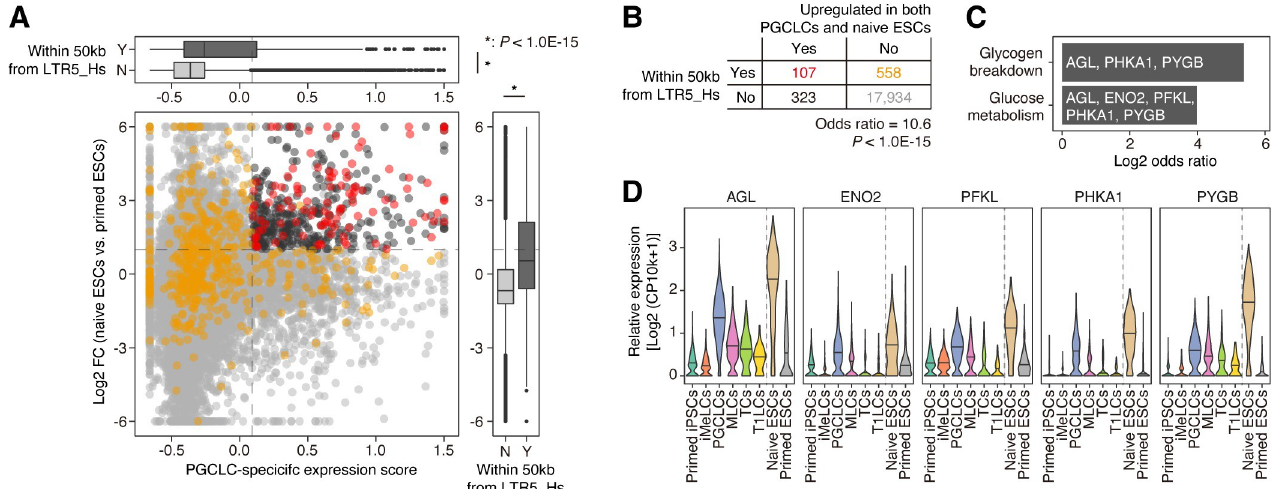
Fig 5. Expression patterns of the genes adjacent to LTR5_Hs in PGCLCs and na ï ve ESCs. (A) Association of the expression patterns of genes and their distance from LTR5_Hs in the genome. The X-axis indicates the PGCLC-specific expression score, and the Y-axis indicates the log2 FC of the expression score in na ï ve ESCs vs. primed ESCs. Genes were stratified according to whether they were present within 50 kb of LTR5_Hs with epigenetic or transcriptomic signals. In the main panel, the genes in the vicinity of LTR5_Hs are colored red or orange. The genes are colored red or black if they were upregulated in both PGCLCs (the top 10% of genes with respect to the PGCLC-specific expression score) and na ï ve ESCs (log2 FC > 1; FDR < 0.05). The color scheme is summarized in ( B ). In the top and right panels, the marginal distributions for the X- and Y-axes, respectively, are shown (Y [Yes], adjacent to LTR5_Hs; N [No], not adjacent). An asterisk denotes P < 1.0E-15 in the two-tailed Wilcoxon rank sum test. (B) Enrichment of the genes adjacent to LTR5_Hs among the genes upregulated in both PGCLCs and na ï ve ESCs. The P value was calculated with Fisher’s exact test. (C) Results of the GO enrichment analysis. The gene sets with significant enrichment (FDR < 0.05) are shown. The names of the hit genes are shown on each bar. (D) Expression patterns of the genes present in the vicinity of LTR5_Hs and related to glucose metabolism.